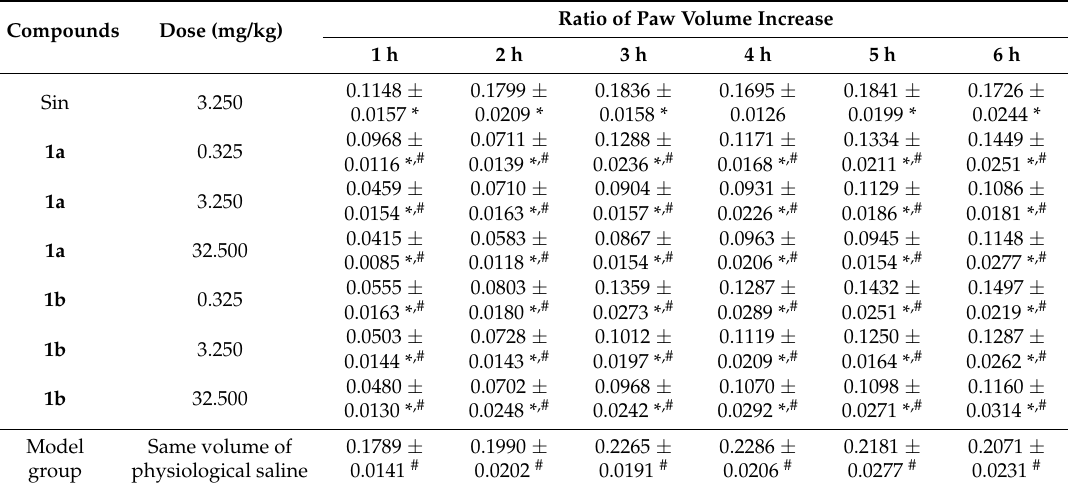
Table 2. Anti-inflammatory effect of Sin and its derivatives on carrageenan-induced paw oedema over time in rats.